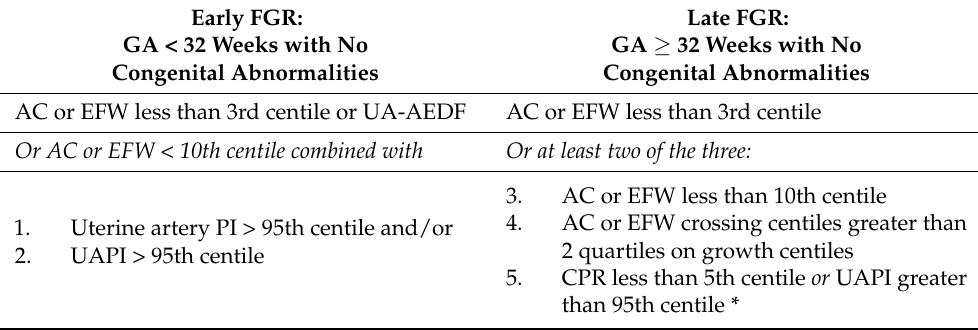
Table 1. Delphi consensus-based definitions for late growth restriction